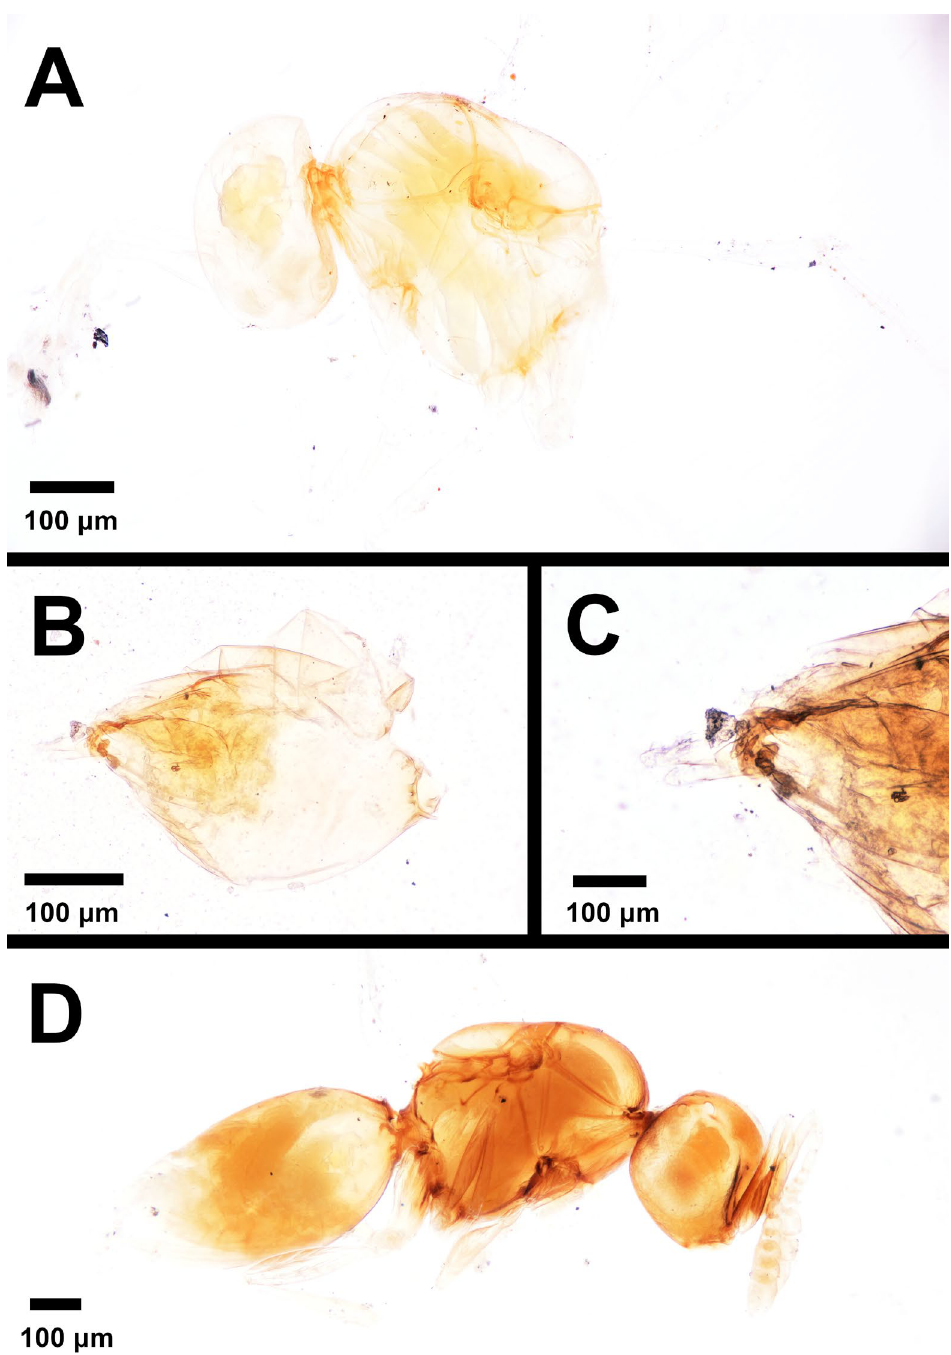
Fig. 6. The two Ceraphron origenus kieffer, 1913 (male and female) syntype specimens that Dessart determined to be Aphanogmus fumipennis Thomson, 1858. A . Lateral habitus of the male specimen in ethanol (MNhN EY25350). B . Male metasoma (MNhN EY22435). C . Close up of the male metasoma with genitalia showing (MNhN EY22435). D . Female specimen in ethanol (MNhN